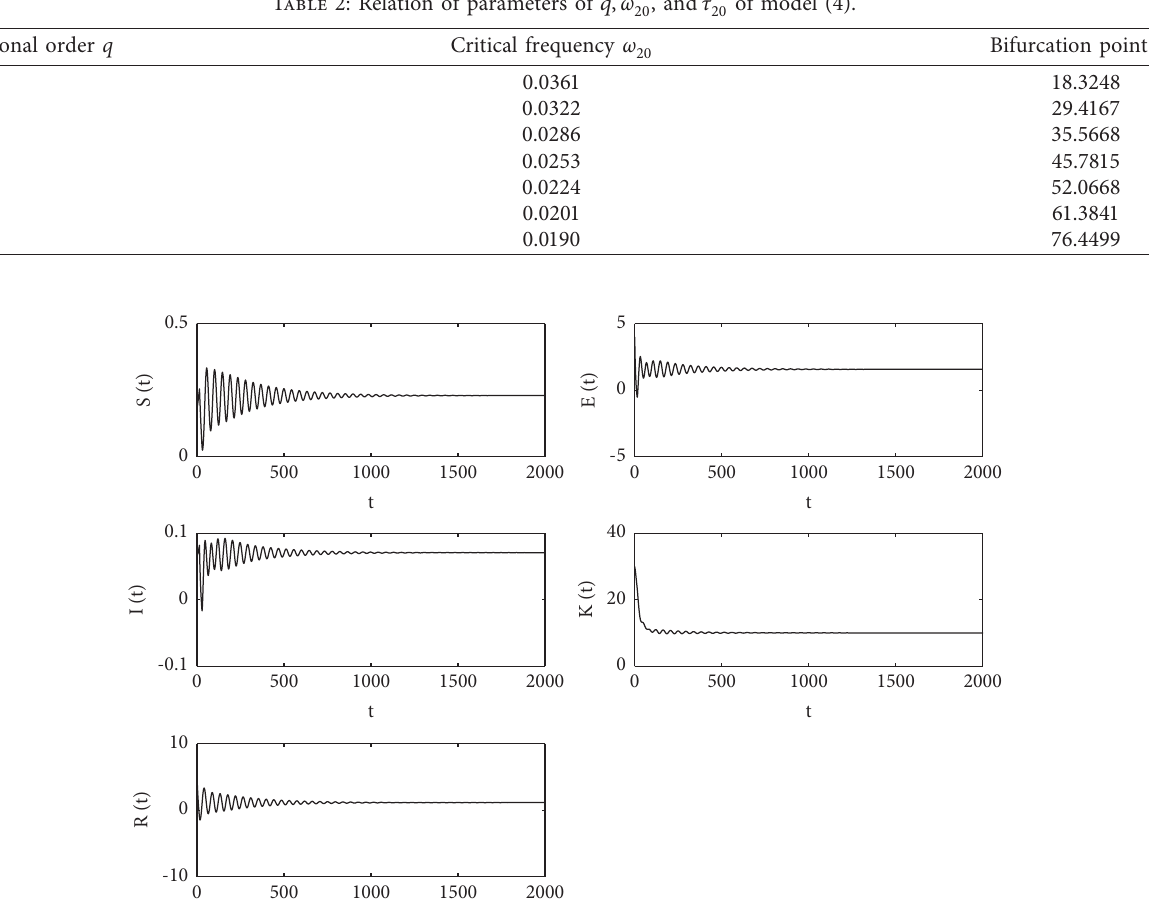
Table 2: Relation of parameters of q, ω